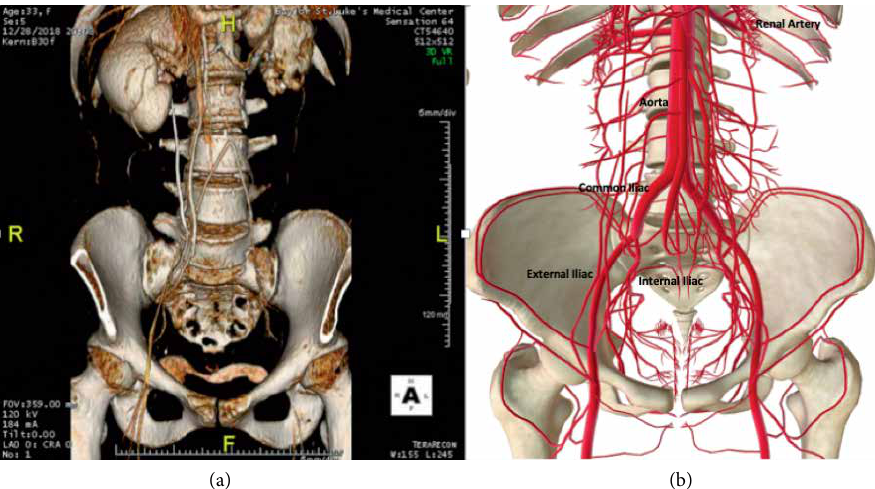
Figure 1: Computed tomography angiogram of the abdomen, pelvis, and lower extremities with runoff (a). Computer generated pelvic vasculature demonstrating the stark difference